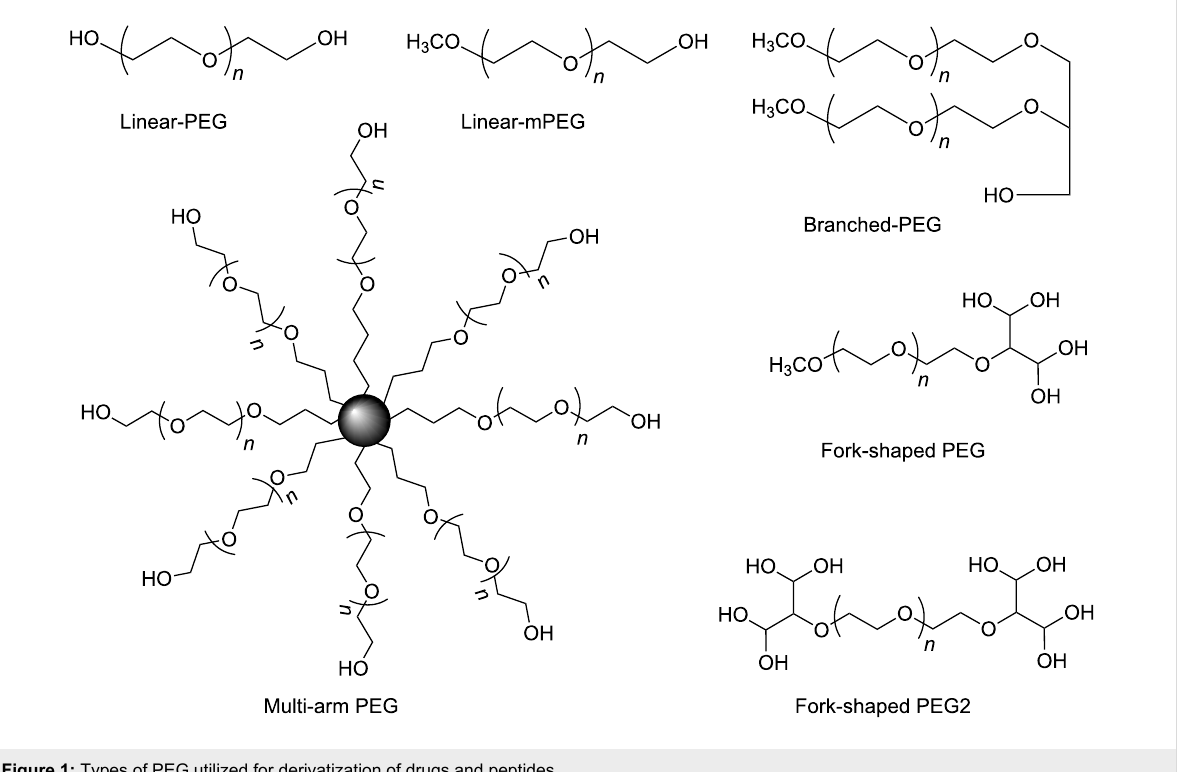
Figure 1: Types of PEG utilized for derivatization of drugs and